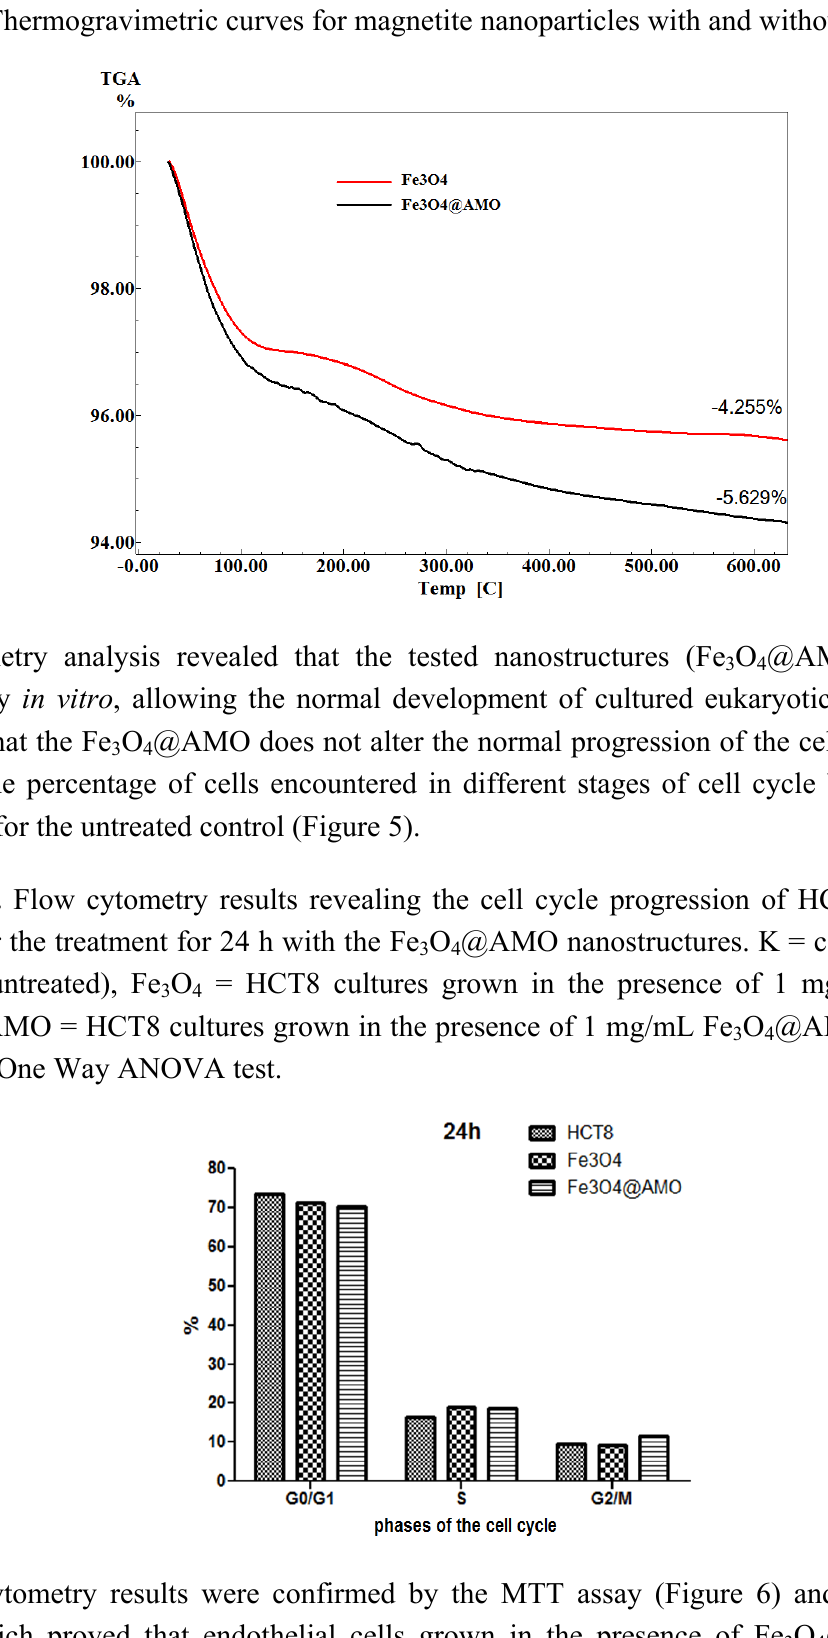
Figure 4. Thermogravimetric curves for magnetite nanoparticles with and without amoxicillin.